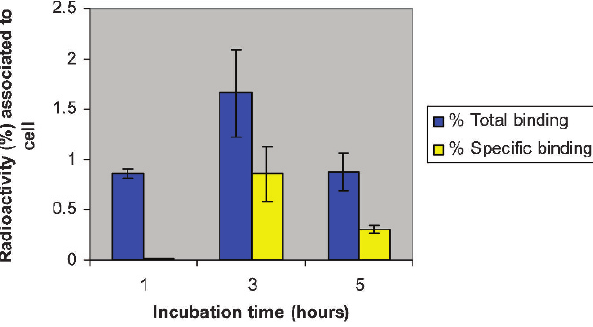
Table 1 - Biodistribution of 99m Tc-MAG 3 -cMORF in Swiss